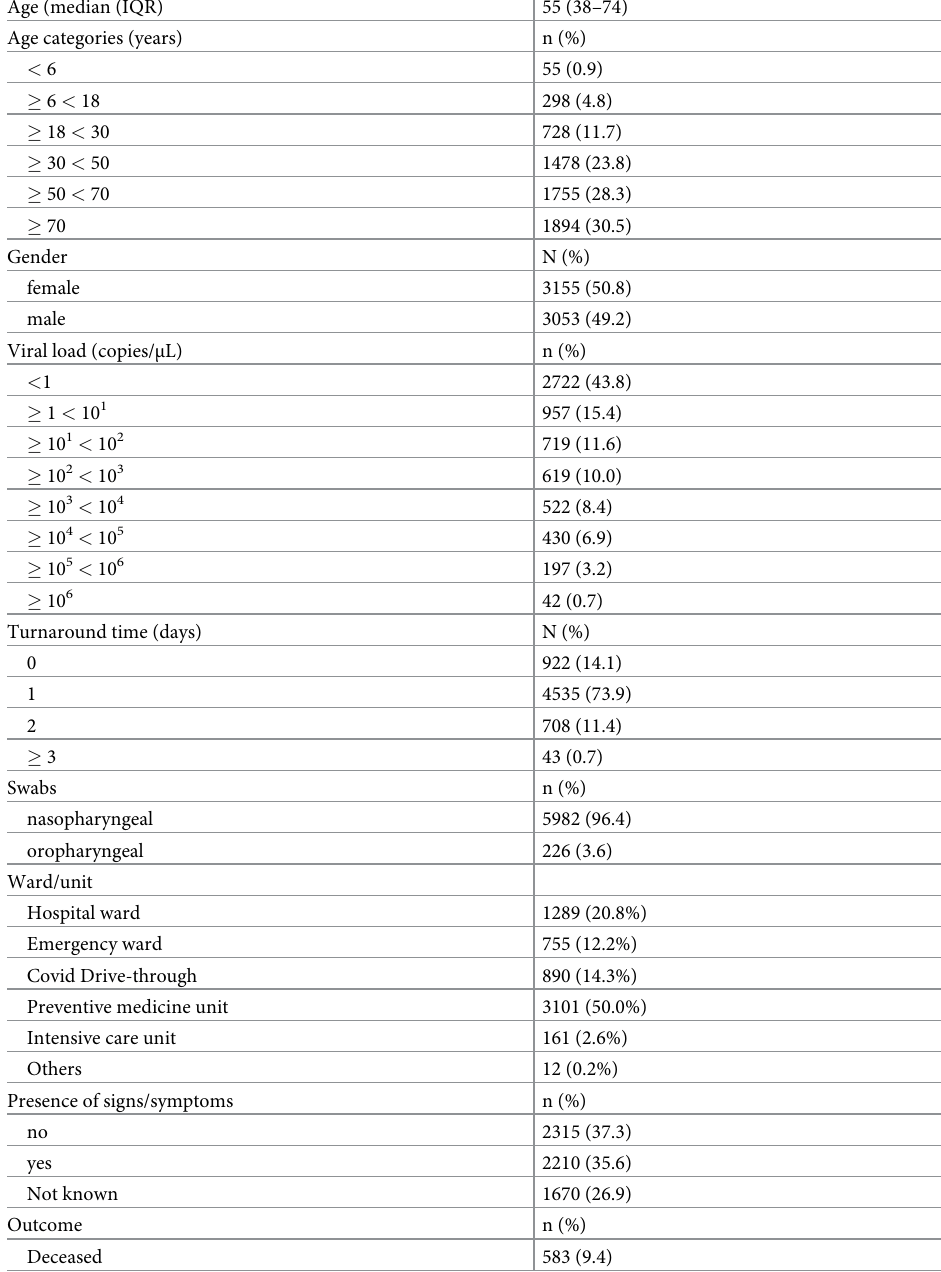
Table 2. Characteristics of the cohort of SARS-CoV-2 positive cases (n =